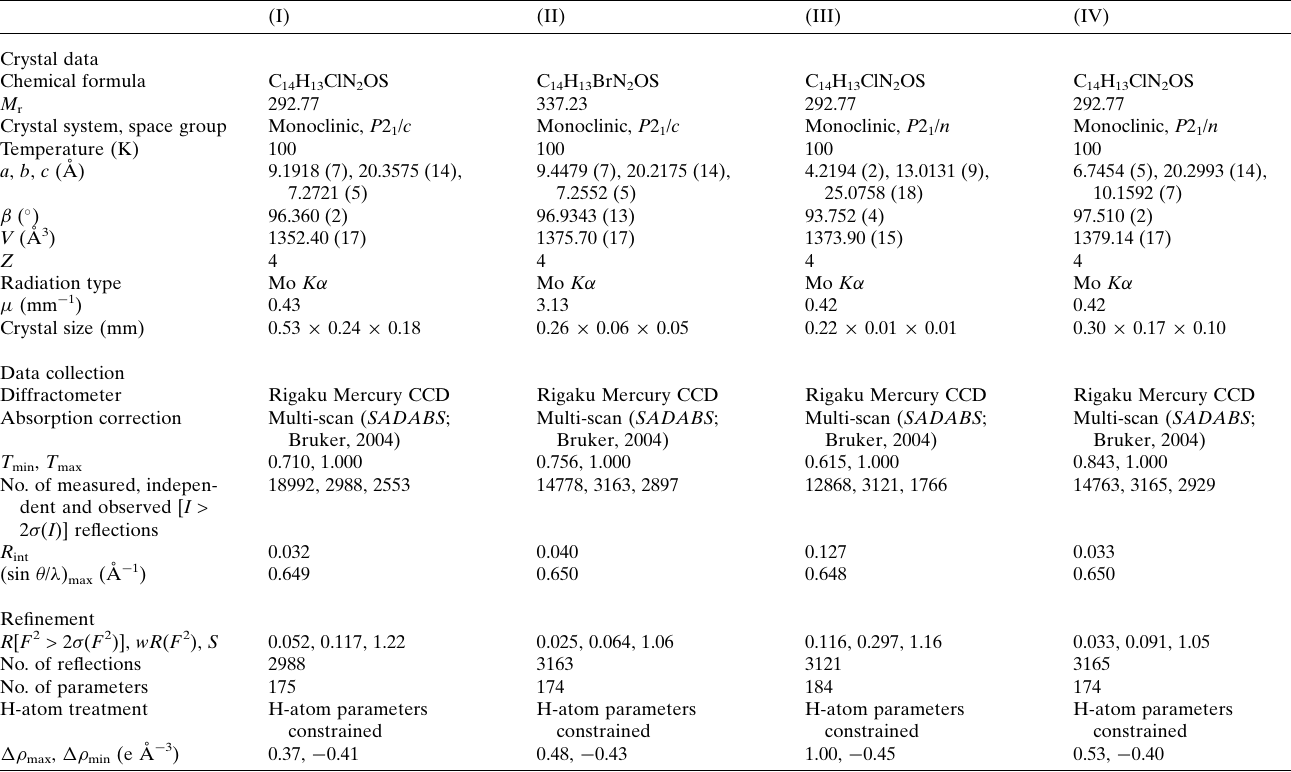
Table 6 Experimental details.